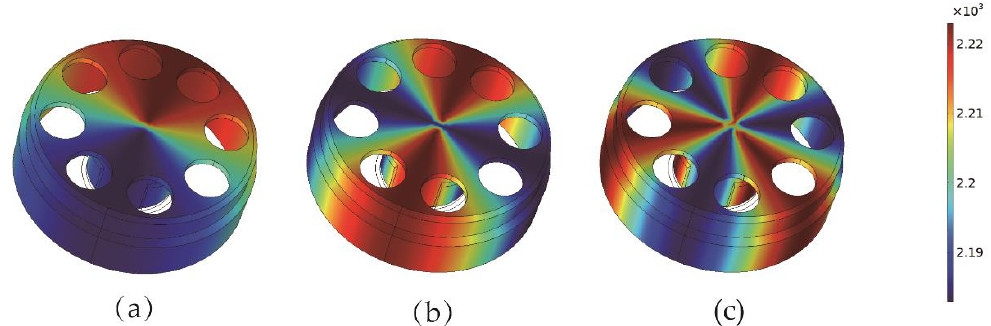
Figure 5. The distribution of the first three nonuniform densities: ( a ) the first harmonic error; ( b ) the second harmonic error; ( c ) the third harmonic error.